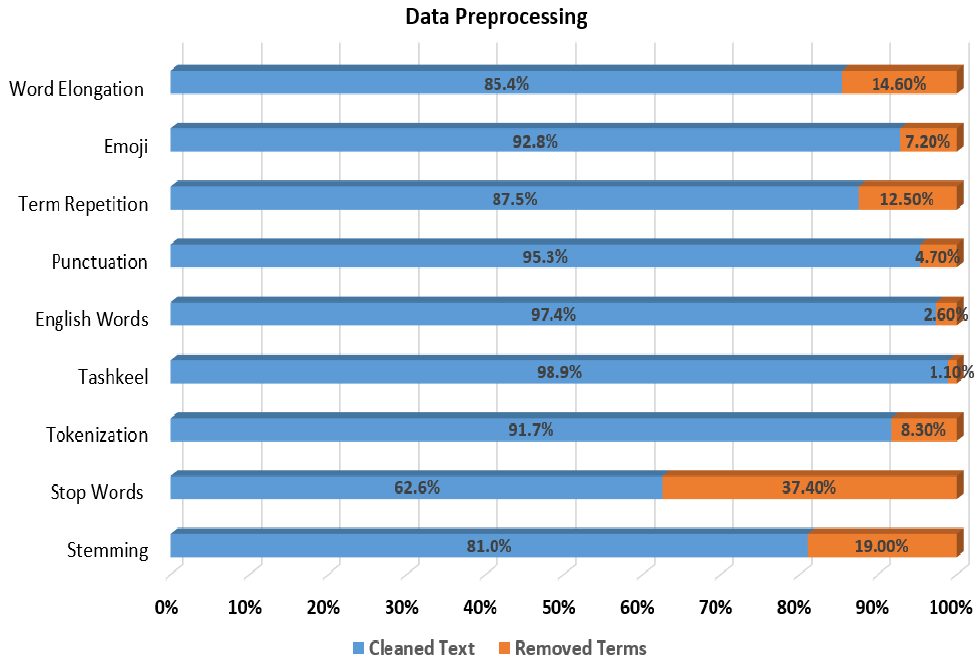
Figure 3. Data preprocessing levels on sentiment analysis documents.